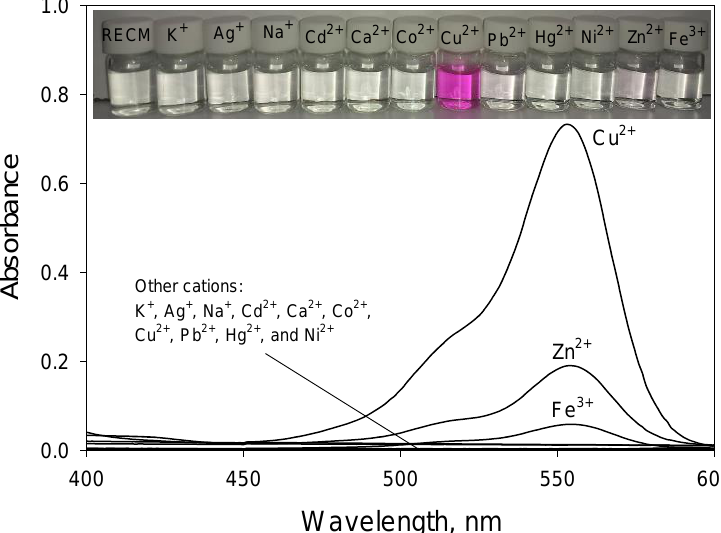
Figure 3. Absorbance spectra of RECM (50 µM) in CH 3 CN in the presence of various competitive cations (30 µM), Inset: Visual color changes of RECM (50 µM) in CH 3 CN in the presence of various competitive cations (30 µM).